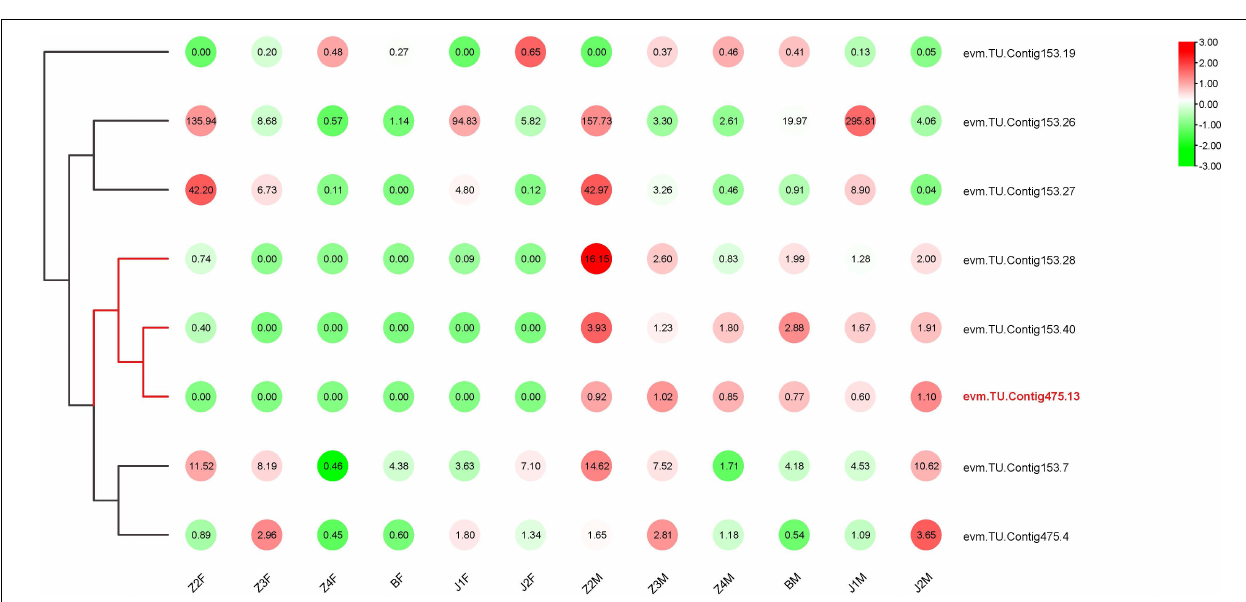
FIGURE 5 | Heat map of DEGs in Contig153 and